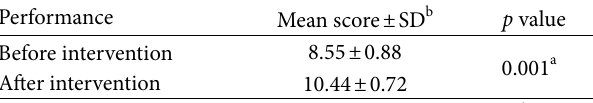
Table 8: Mean score of DPI before and after intervention. a p value less than 0.05 is considered statistically significant. b Standard Deviation. Table 9: Percentage of patients performing each step correctly. S.no.